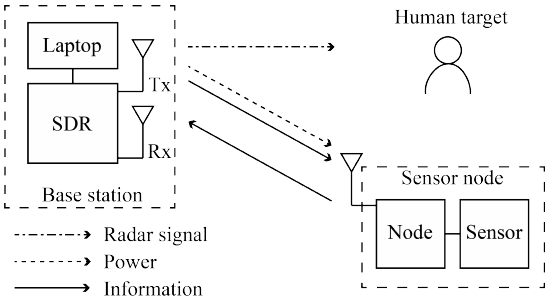
Figure 1. Top-level representation of the proposed three-mode